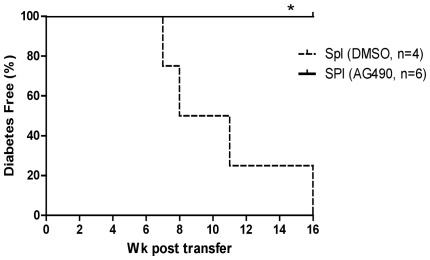

In vivo AG490 treated splenocytes did not transfer diabetes to NOD.Scid mice.Prediabetic NOD mice (4- weeks of age) were treated with AG490 or DMSO for five consecutive week (n = 5 per group), three times per week and mice were sacrificed one week after the last injection at week 10. Splenocyte cell suspension of pooled mice immediately prepared and dead cells and red blood cells were removed by Histopacque gradient separation method and freshly isolated splenocytes containing >99% viable cells were transferred (5×106, i.p) into NOD.Scid mice. Blood glucose in recipient mice was monitored at least once a week as described earlier (*: p = 0.02, Kaplan-Meier test).